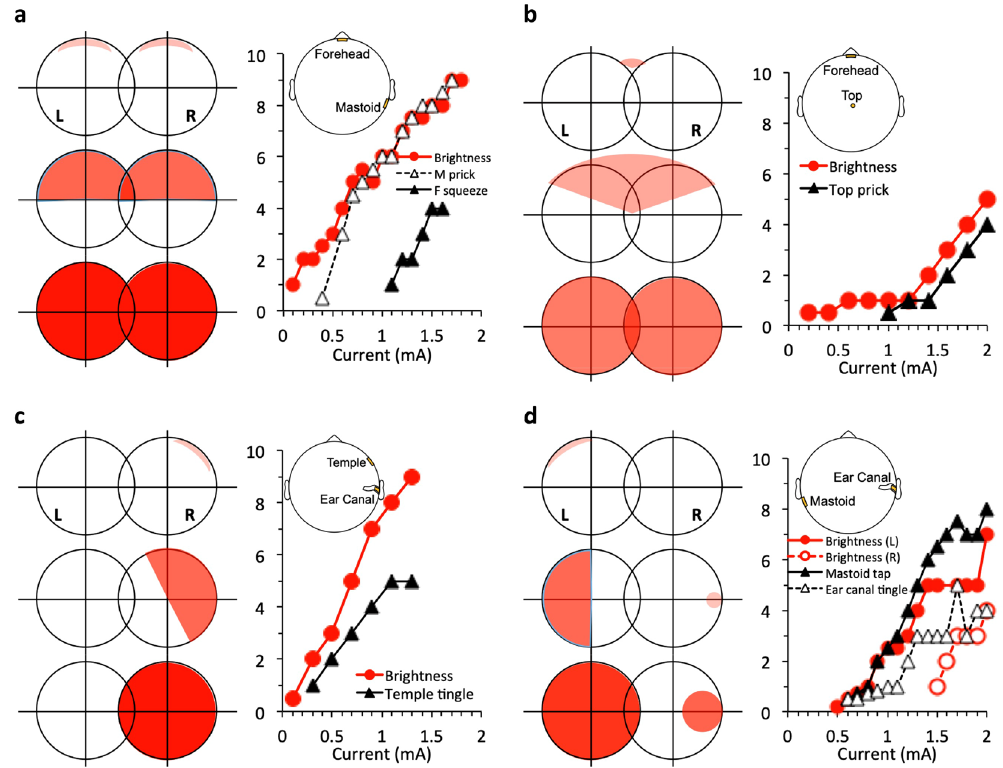
Figure 2. Left and right fields (L and R circles) of visual sensation and magnitude estimates as a function of electric current in mA (line-scatter charts). The top, middle, and bottom visual fields indicate threshold, mid, and upper level sensations. All stimuli were at 10 Hz. (a) Forehead and right mastoid plate electrodes. (b) Forehead plate electrode and top (Cz) cup electrode. (c) Right ear canal tiptrode and right temple plate electrode. (d) Right ear canal tiptrode and left mastoid plate